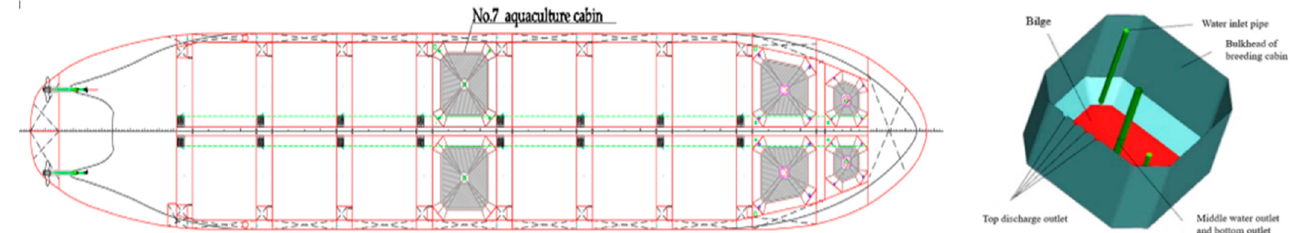
Figure 1. Geometric model of aquaculture cabin.